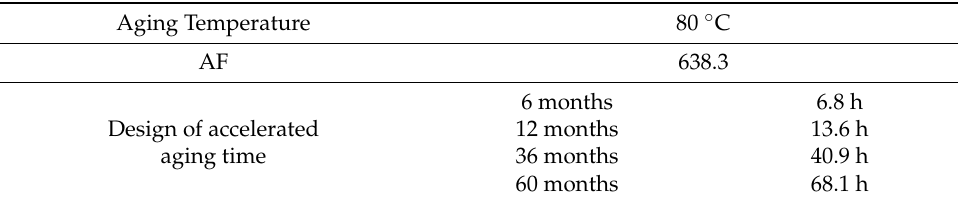
Table 2. Design of accelerated aging time.